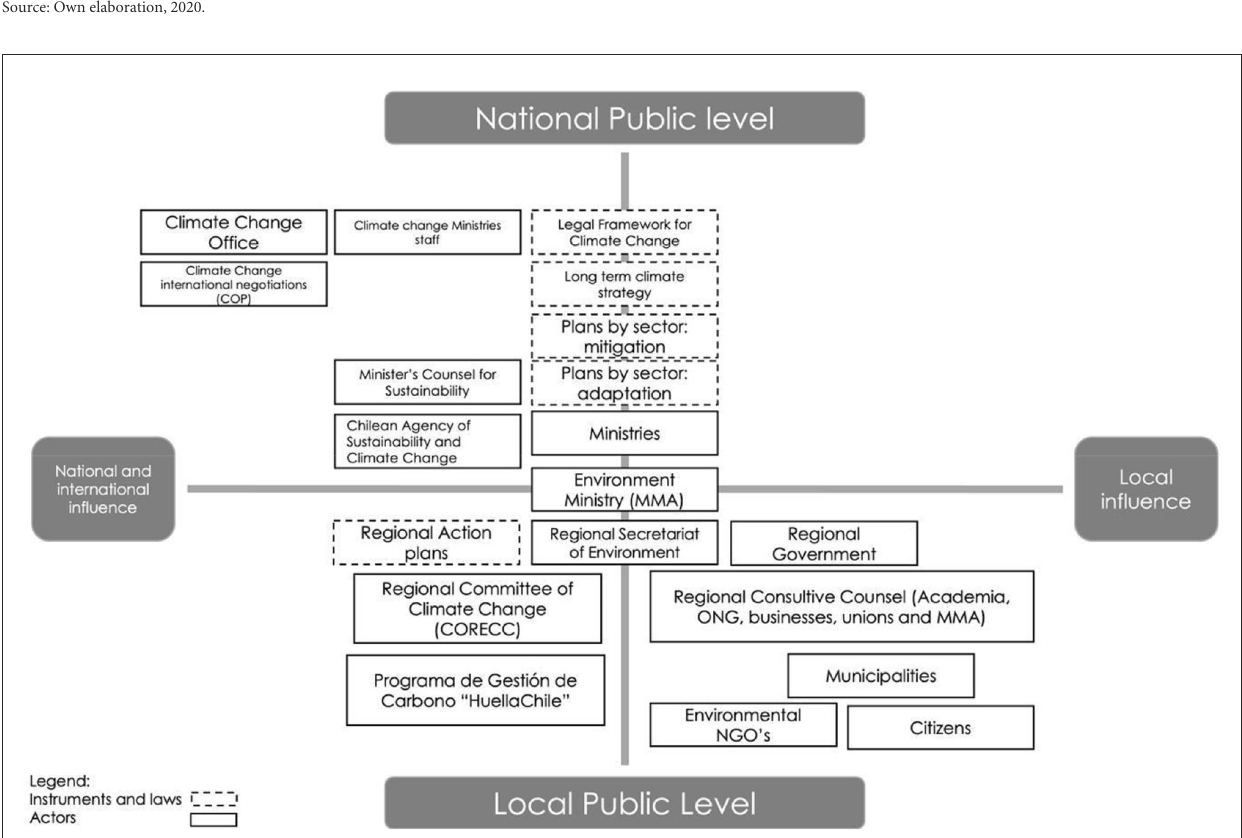
FIGURE3 Diagram of the multi-scale climate governance for Chile based on normative documents. Source: Adapted from Centro UC de Políticas Públicas (2021), Ministerio del Medio Ambiente (MMA) (2021b).